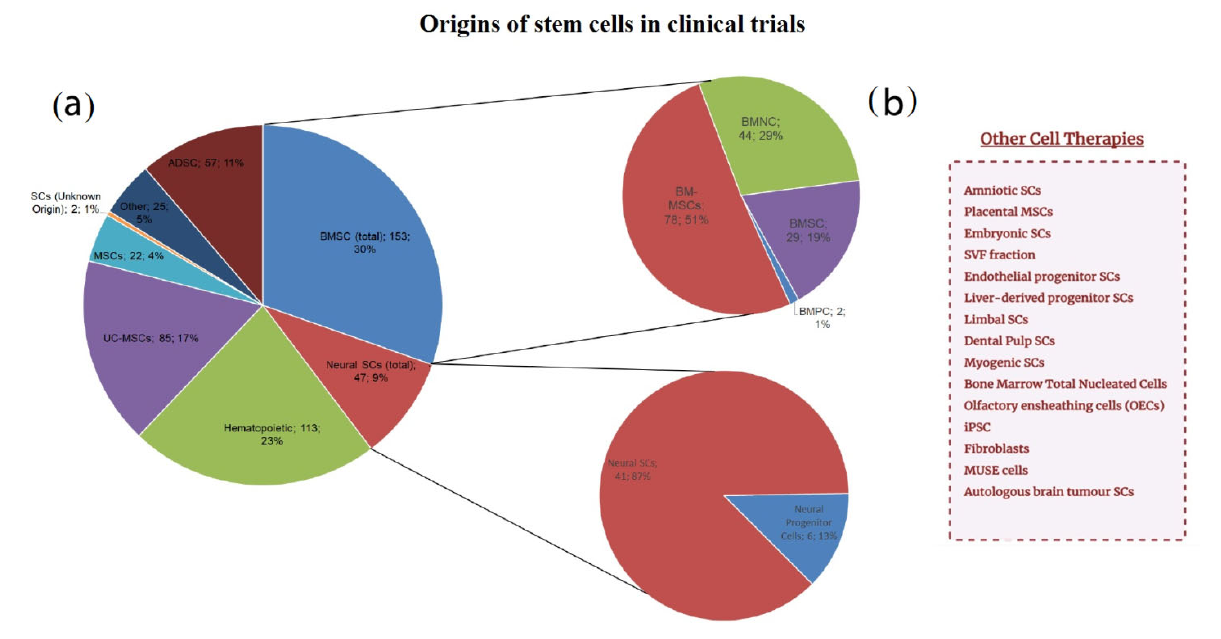
Figure 3. This figure contains information about various stem cell origins mentioned in the clinical trials. Stem cells derived from bone marrow (BMSC) were the largest group accounting for